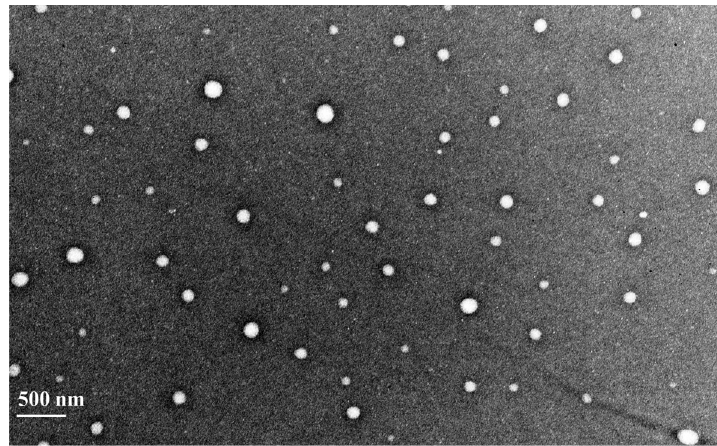
Figure 2. TEM image showing the spherical shape of η Cur.